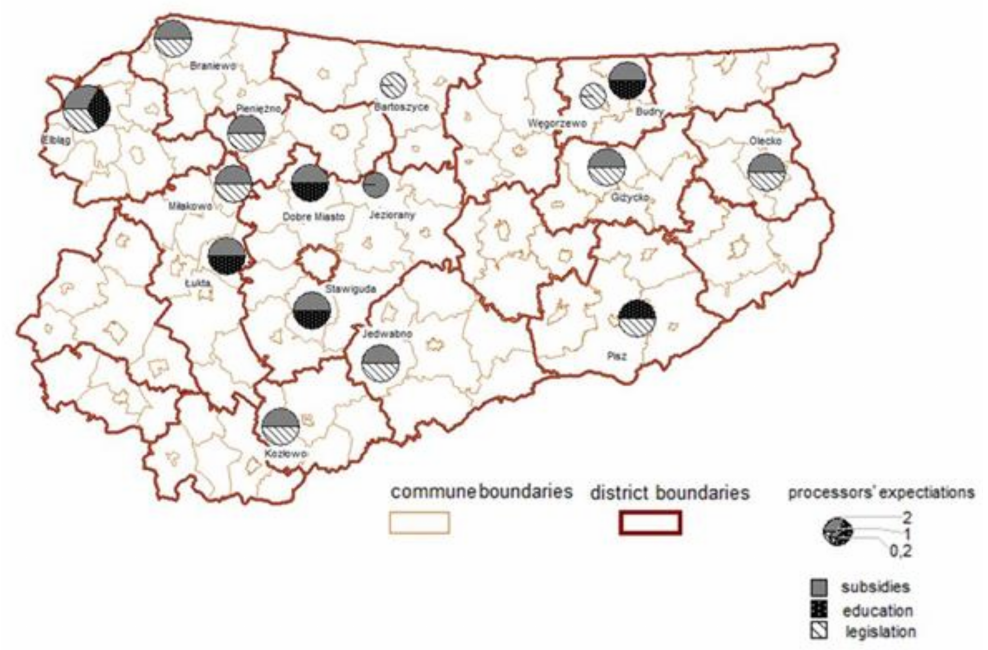
Figure 6. The required measures supporting the development of the biomass market according to the surveyed biomass processing companies in the Region of Warmia and Mazury. Source: